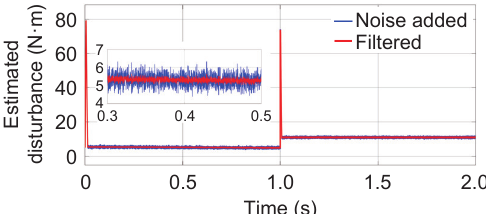
Fig. 15 Waveform of estimated disturbance before and after being